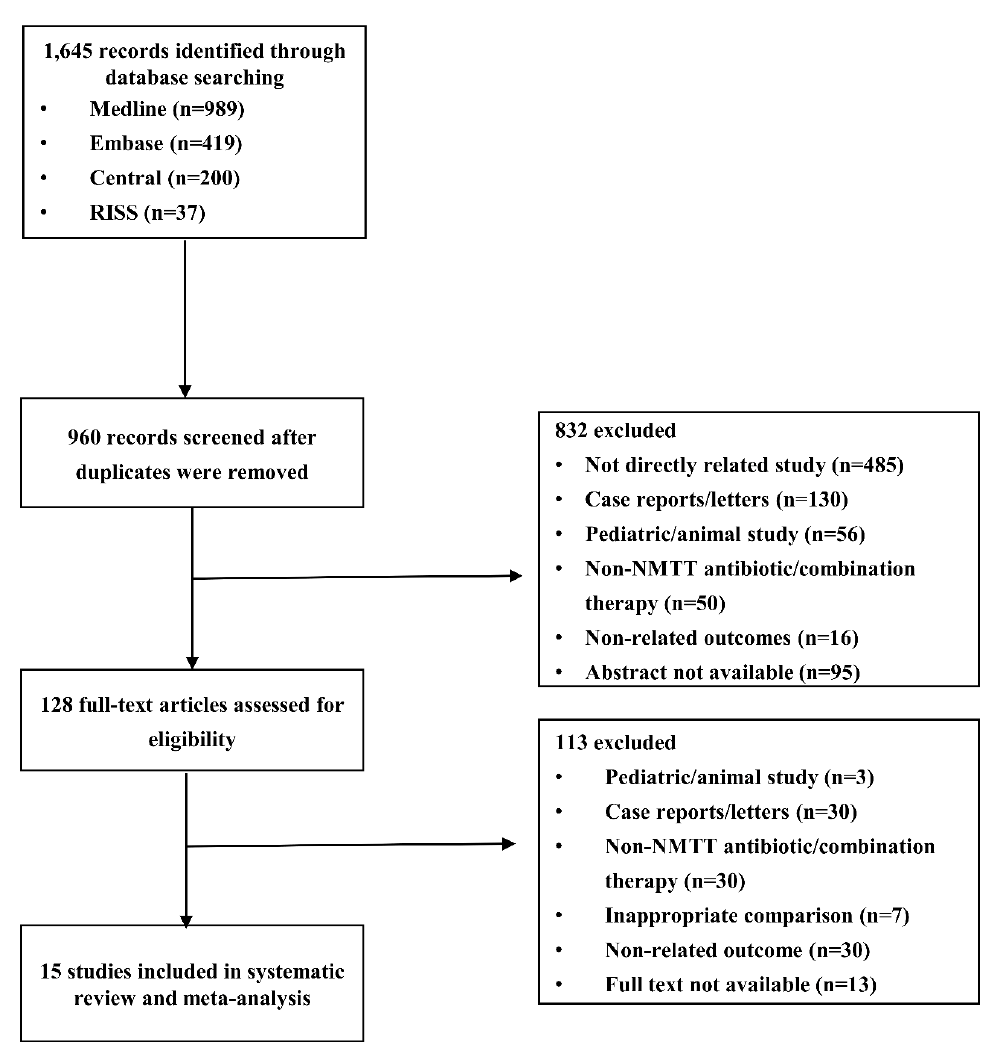
Figure 1. Flow chart of the study selection process.